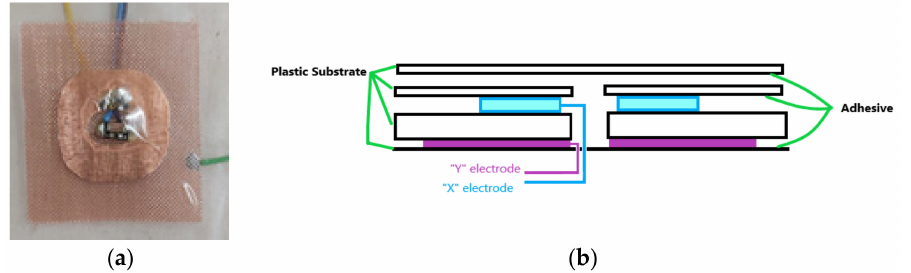
Figure 8. ( a ) Capacitive touch sensor (Capacitive Touch Sensor 2—CTS2) (item 4 in Figure 3b), and ( b ) construction